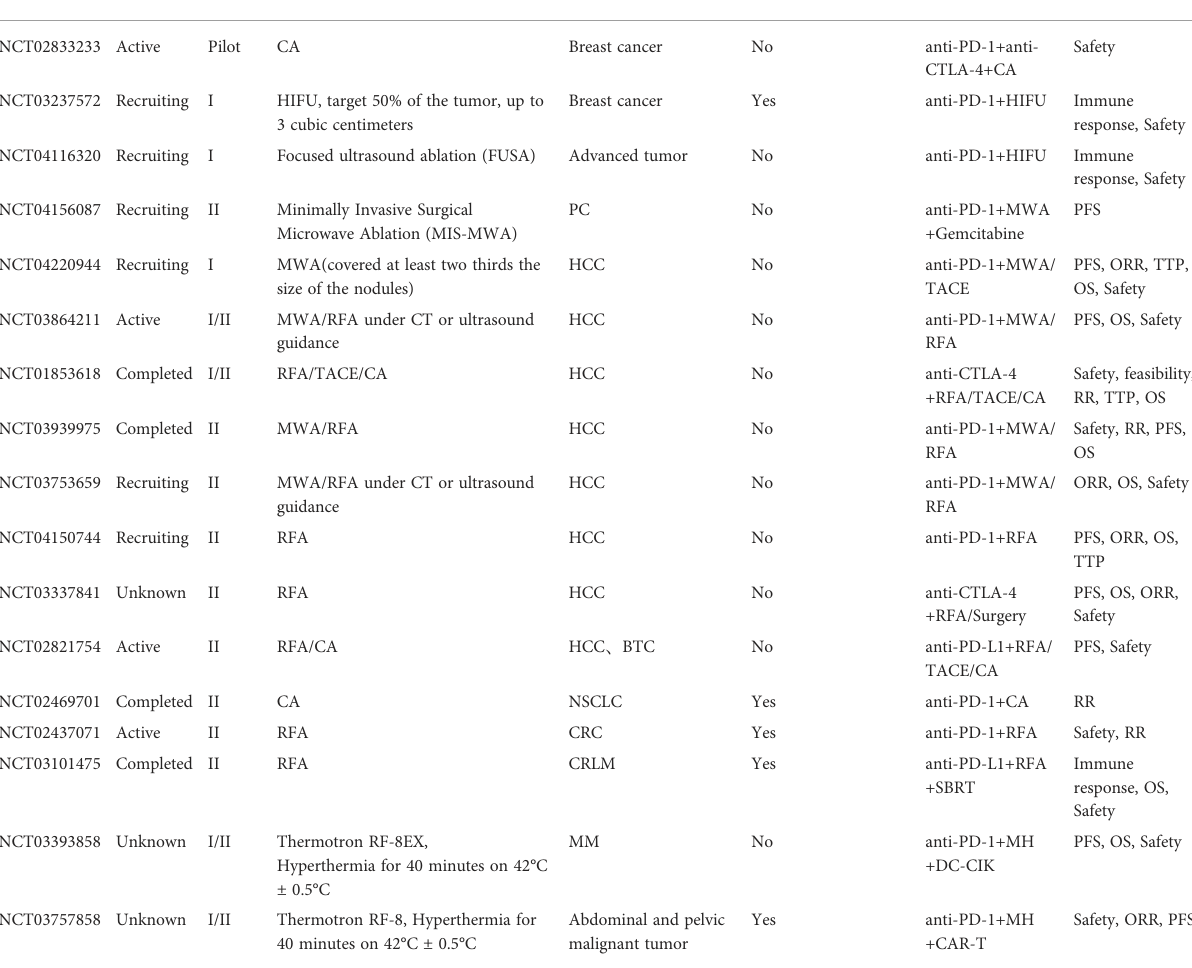
TABLE 1 Examples of ongoing clinical studies combining ICIs with hyperthermia therapy.